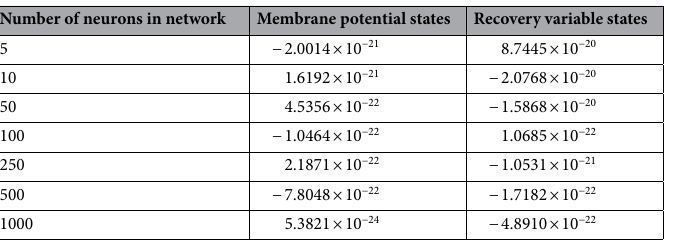
Table 3. Mean errors in the synchronization dynamics of the membrane potential states and recovery variable states for different-sized unidirectional networks of FHN neurons with noise.